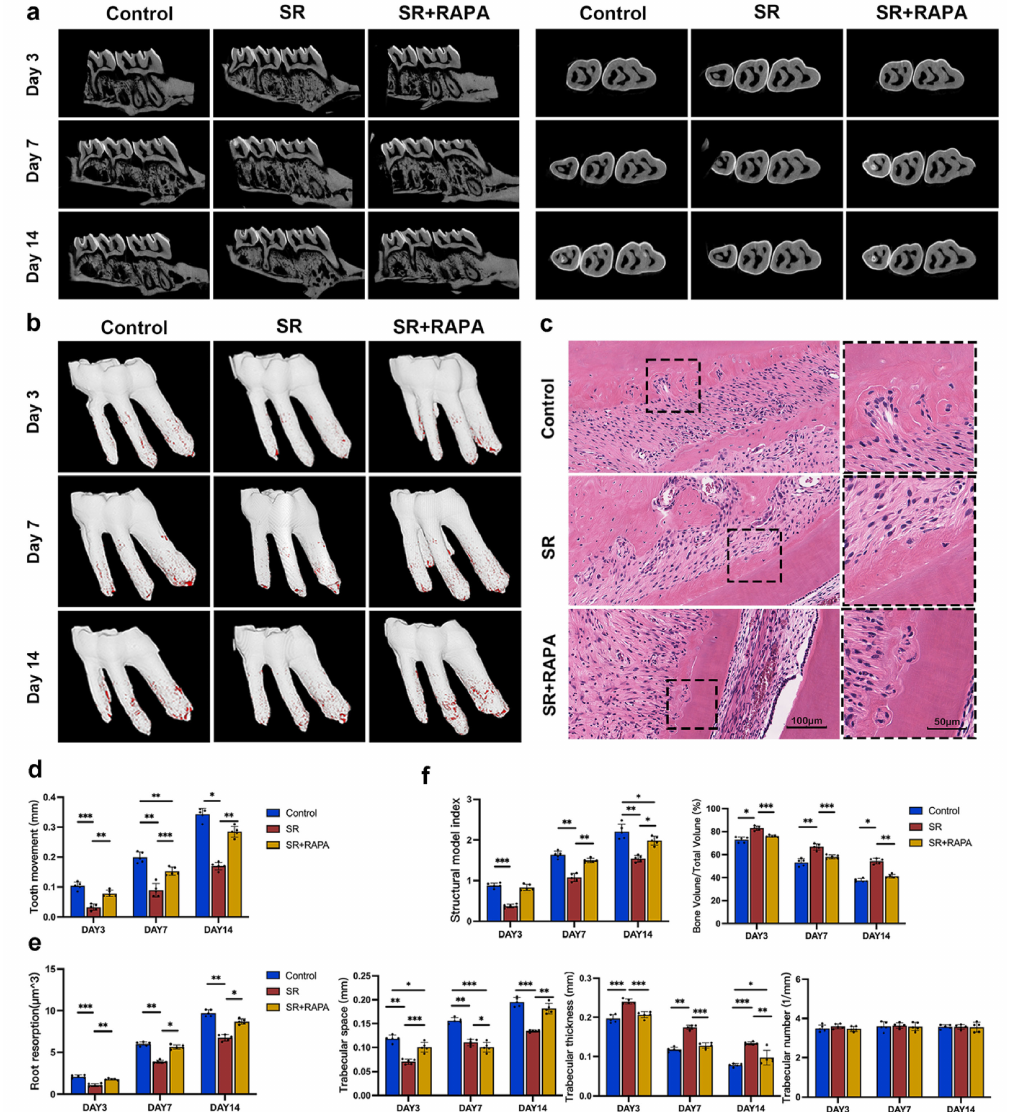
Figure 3. Strontium ranelate reduced orthodontic tooth movement and root resorption in rats. Three- dimensionally reconstructed micro-CT images of orthodontic tooth movement ( a ) and root